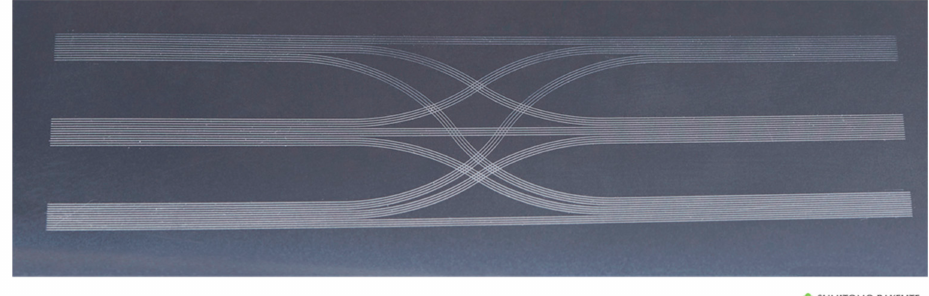
Figure 6. Photo-addressed waveguides with waveguide layout showing multiple cross-overs at varied crossing angles (Source: Sumitomo Bakelite).